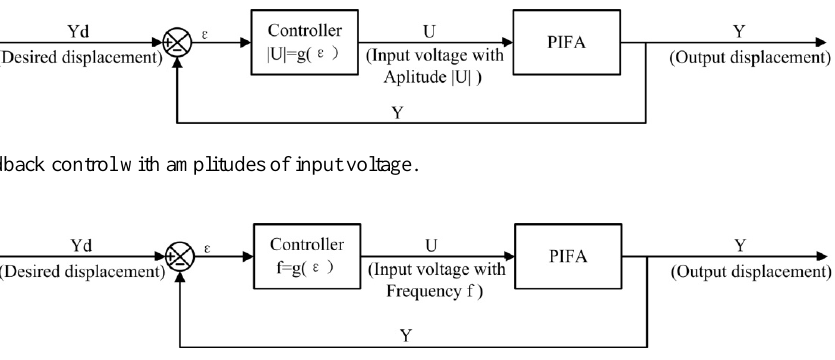
Figure 11. Position feedback control with frequency of input